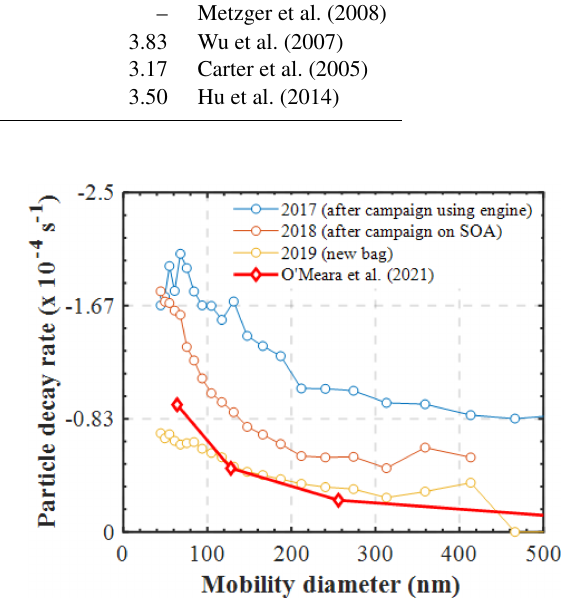
Figure 6. Measured size-dependent particle decay rates (s − 1 ) in characterisation experiments (RH = 50%) conducted under differ- ent conditions of the bag. The modelled particle losses in a nucle- ation experiment are shown for comparison (O’ Meara et al.,